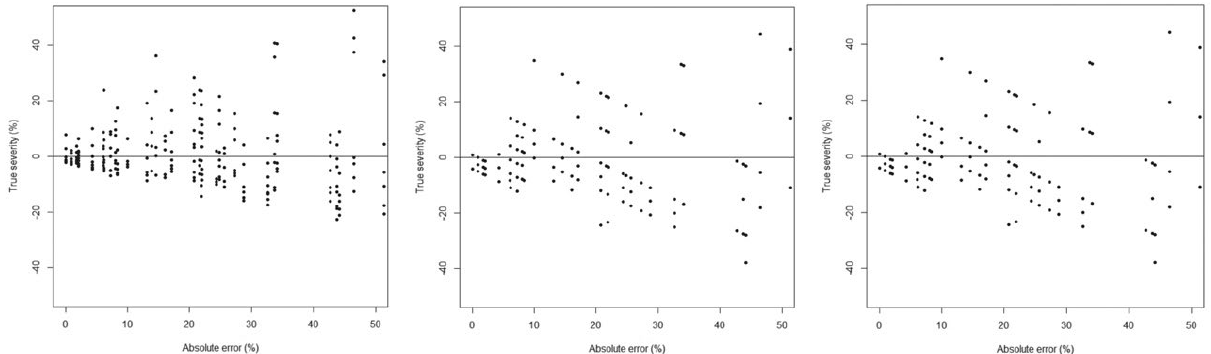
Figure 2. Distributions of residuals (estimated severity – actual severity) of estimates of rust severity on fig leaves, with or without the use of the disease severity scale, in two assessments by eight